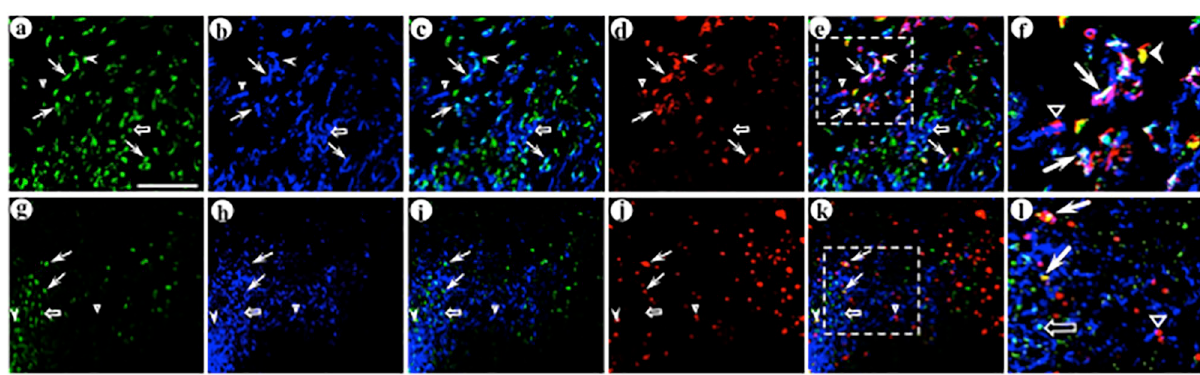
Fig 10. This synthetic peptide neurotransmitter supports gene transfer to the calbindin-containing subtype of GABAergic neurons. The experimental design and immunofluorescent costaining were as above, but calbindin-IR was assayed instead of parvalbumin-IR. (A-F) Image stacks show neuronal morphology for the transduced postsynaptic dendrites and cell bodies, proximal to transduced axons; (A) His tag-IR (fluorescein- conjugated secondary antibody), (B) GFP-IR (Alexa Fluor 633-conjugated secondary antibody), (C) merge of His tag-IR and GFP-IR, (D) calbindin-IR (TRITC-conjugated secondary antibody), (E) merge of all three IR, (F) merge, an enlarged area showing adjacent transduced axons and dendrites that contain calbindin-IR. Arrow, a transduced axon proximal to a transduced dendrite, with calbindin-IR. Open arrow, a transduced axon proximal to a transduced dendrite that lacks calbindin-IR. Arrowhead, a transduced axon distant from a transduced dendrite, but proximal to calbindin-IR. Open triangle, a transduced dendrite that contains calbindin-IR, but distant from a transduced axon. (G-L) Single confocal images in each channel show that delivery of the presynaptic vector, followed by the targeted postsynaptic vector, supported gene transfer across GABA A ß2- or ß3-containing synapses to calbindin-containing postsynaptic neurons; (G) His tag-IR, (H) GFP-IR, (I) merge of His tag-IR and GFP-IR, (J) calbindin-IR, (K) merge of all three IR, (L) merge, an enlarged area showing adjacent transduced axons and dendrites that contain calbindin-IR. Panels G-L show a different field than for panels A-F. Scale bar: 20 μ m.